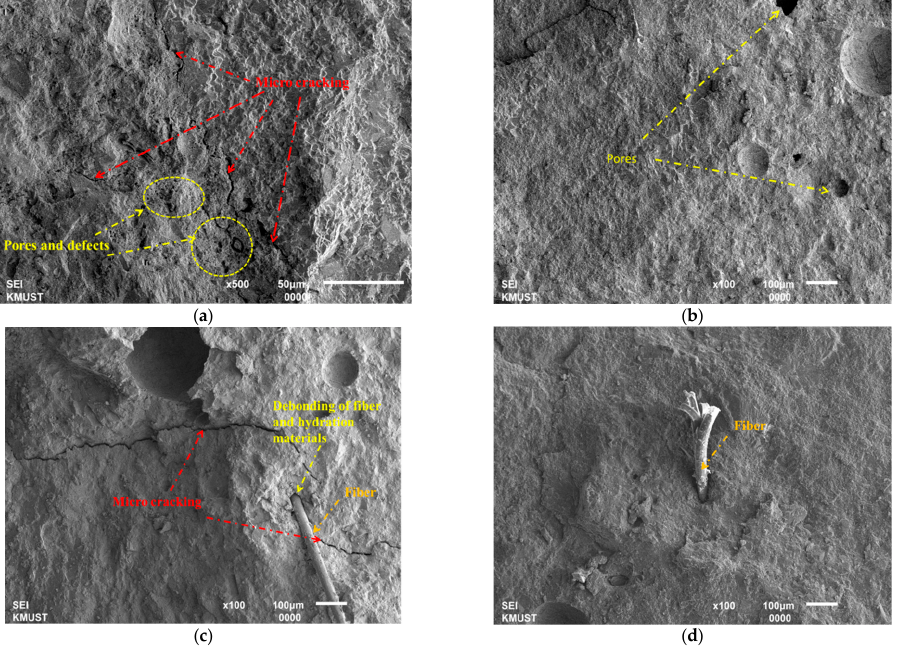
Figure 20. ( a ) SEM image of conventional concrete. ( b ) SEM image of polymer modification only. ( c ) SEM image of fiber reinforcement only. ( d ) SEM image of fiber reinforcement and polymer modification.